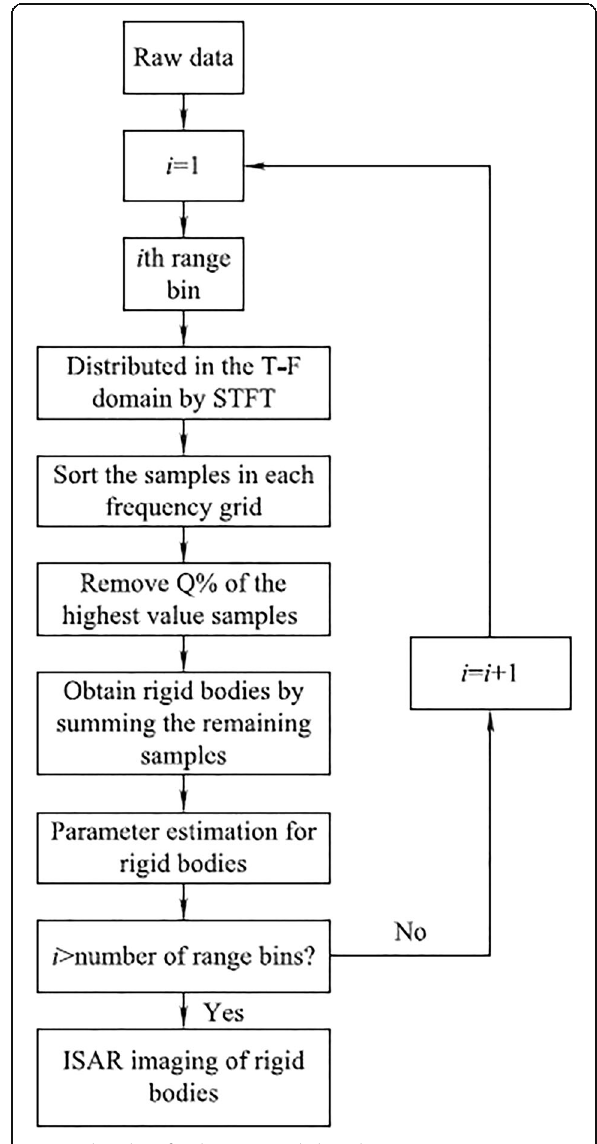
Fig. 6 Flowchart for the proposed